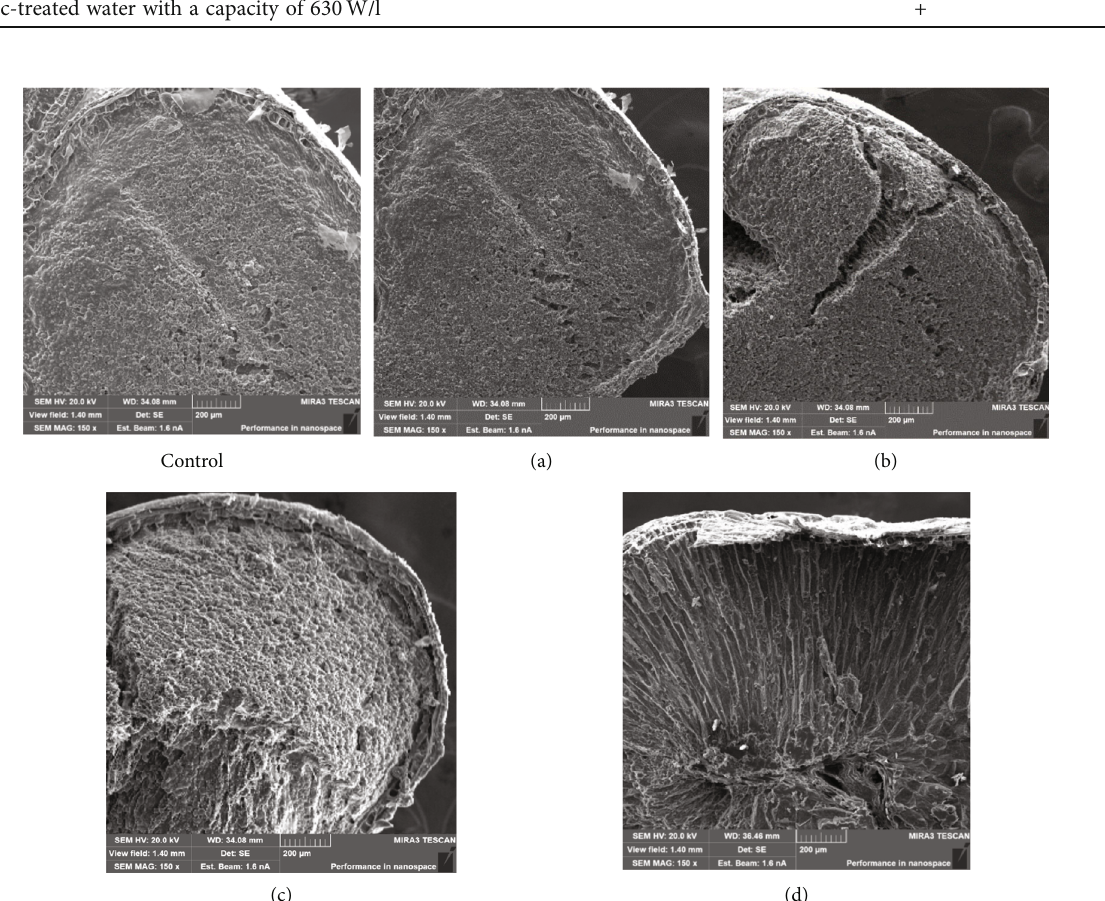
Figure 1: Characteristic view of electronic microphotographs of the cross-section of the control and experimental (a – d) wheat grain samples (Sample 1) after 8 hours of soaking, TESCAN MIRA3 SEM, magni fi cation